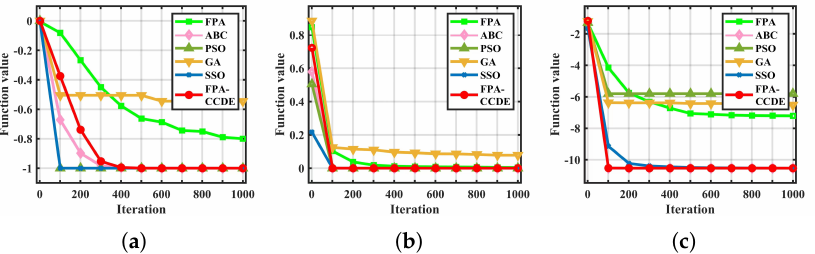
Figure 2. Fitness value graphs of benchmark functions: ( a ) the fitness value of F2; ( b ) the fitness value of F19; ( c ) the fitness value of F30.